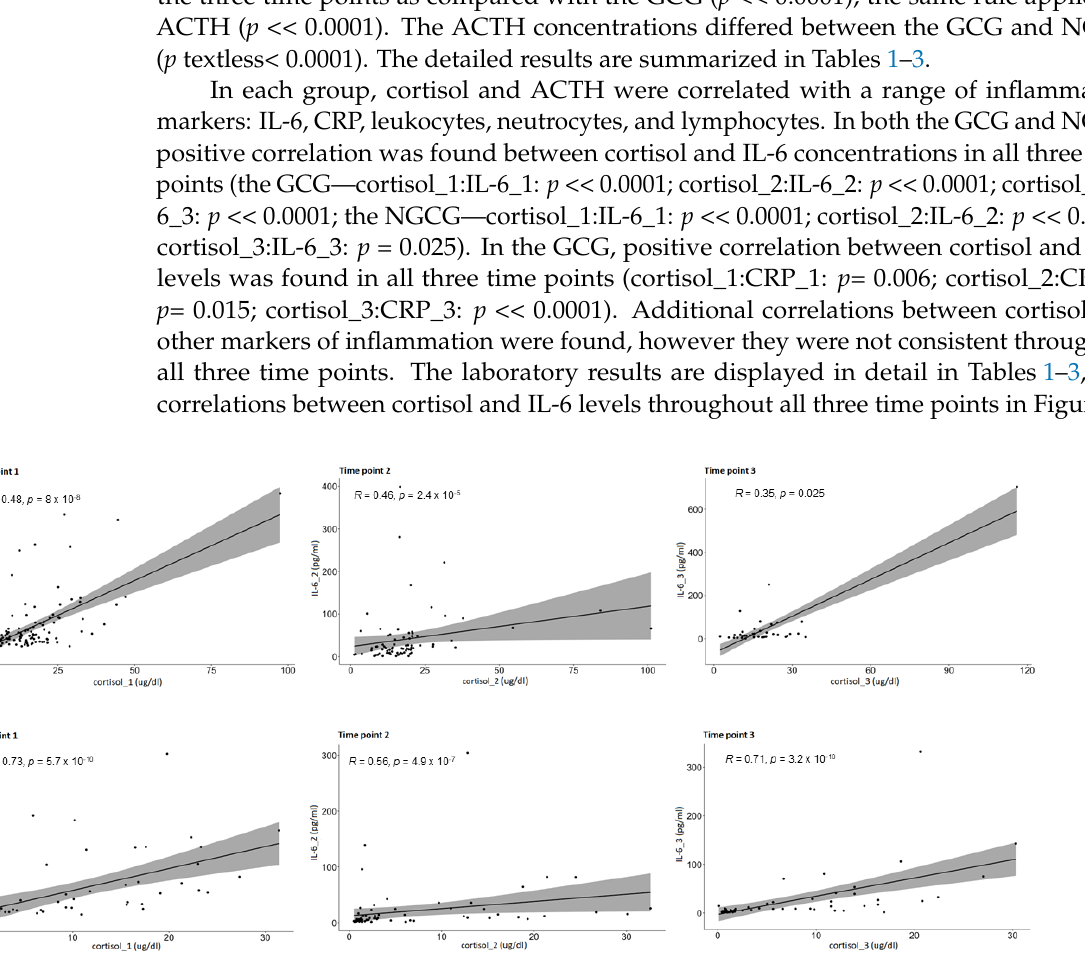
Figure 2. The correlations between cortisol and IL-6 levels throughout the three time points. ( A ) The NGCG, ( B ) the